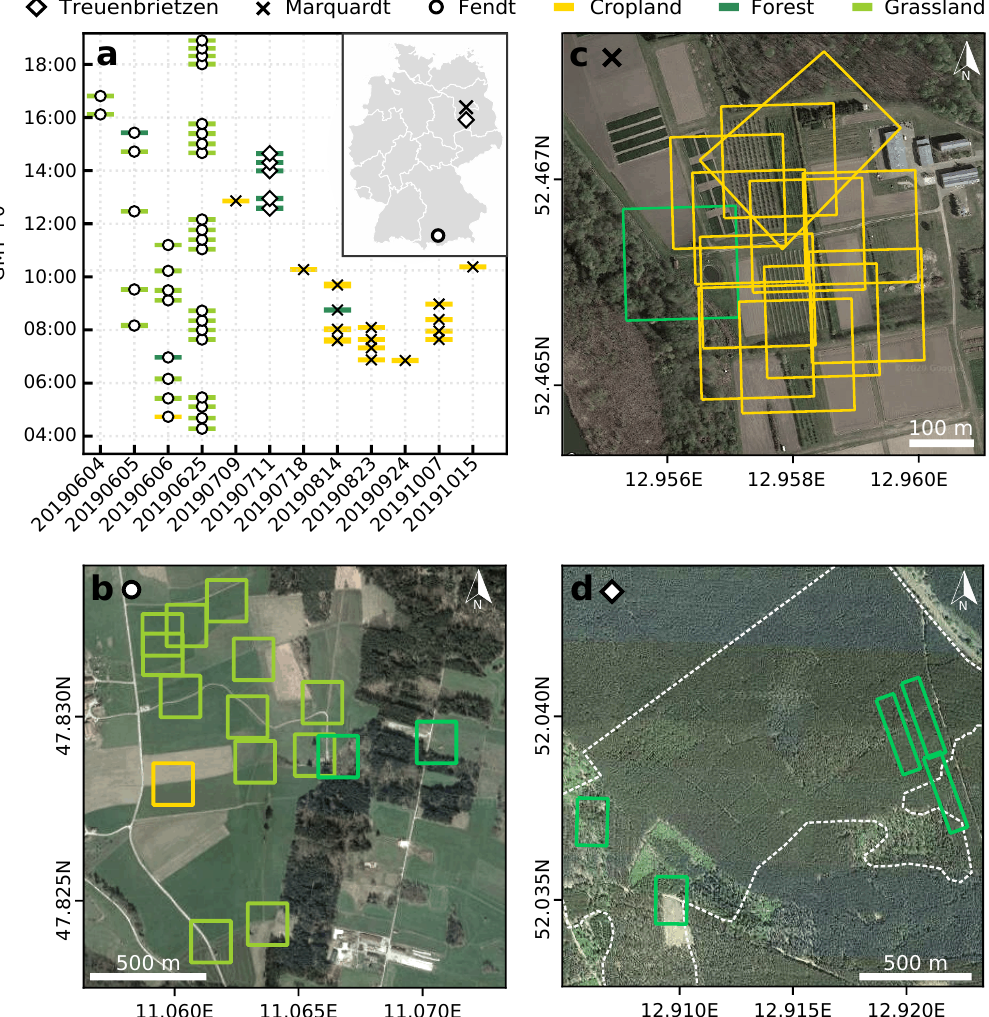
Figure 1. Areas overflown by site, land cover, date, and time. ( a ) Schedule, site, and land cover of different data acquisitions. ( b ) Flights and assigned land cover type for Fendt, ( c ) Marquardt, ( d ) and for Treuenbrietzen. (Basemap: Satellite Google, Imagery 2020, GeoBasis-DE/BKG, GeoContent, Maxar